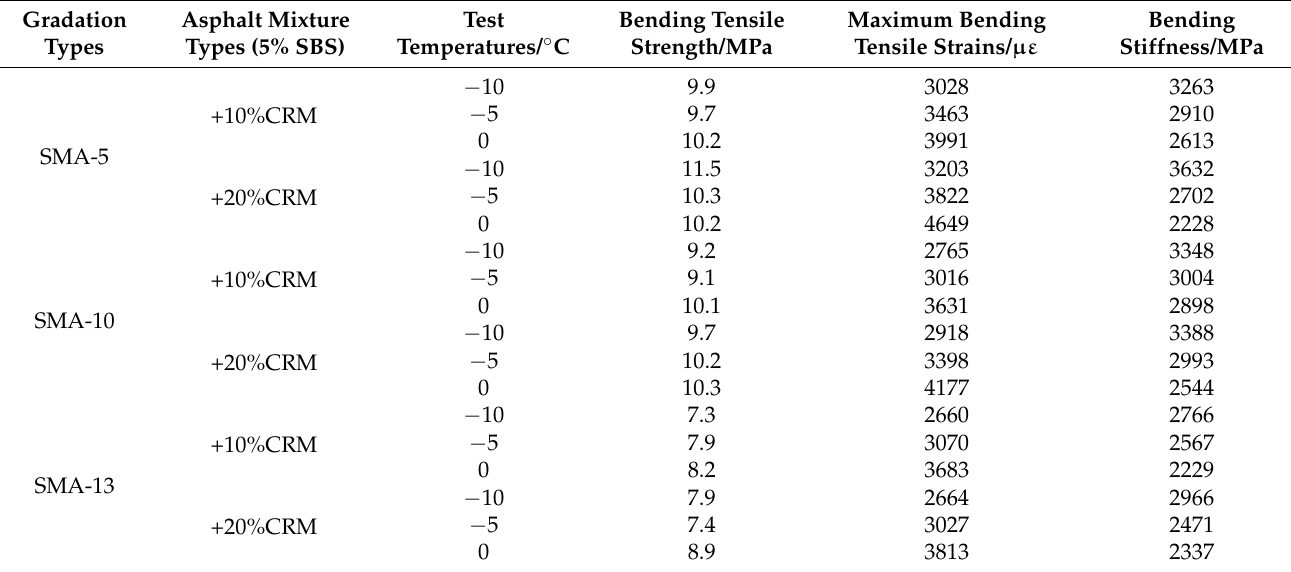
Table 10. Bending beam test results of asphalt mixtures.